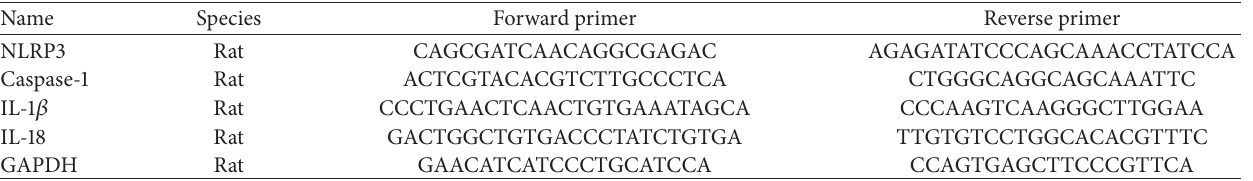
Table 1: Names and sequences of primers used for quantitative